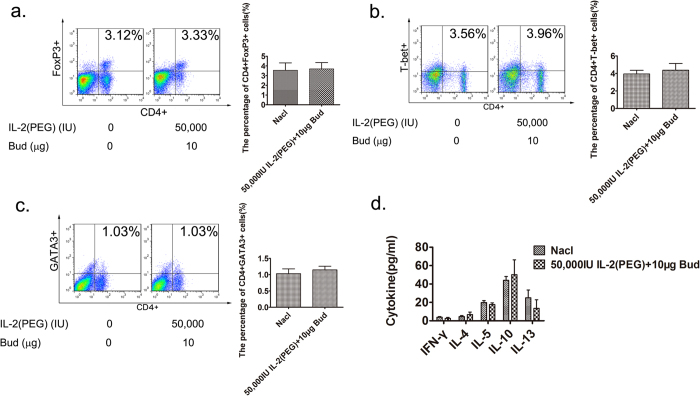
Detection of Th2 and Treg cells and cytokines after drug intervention.The combined use of glucocorticoid and IL-2 had no obvious impact on the whole body. Female BALB/c mice were immunized with OVA i.p on days 1 and 8, followed by intranasal (i.n) 2% OVA challenges on days 9–14. 50,000 IU IL-2 plus 10 μg budesonide (Bud) were administrated intratracheally on days 12–14. On day 15, mice were sacrificed and analyzed by flow Tcytometry or ELISA. (a–c) Detection of CD4+FoxP3+ Treg cells, CD4+T-bet+ Th1 cells and CD4+GATA3+ Th2 cells in spleens after 3 days use of 50,000 IU IL-2(PEG) combined with 10 μg budesonide (Bud) by flow cytometry. (d) Measurement of cytokines by ELISA in serum after 3 days use of 50,000 IU IL-2(PEG) combined with 10 μg Bud. Data are presented as means ± SEM (n ≥ 6 per group and data point) from 2 independent experiments. p > 0.5. Treated group versus untreated group by Student’s t test.